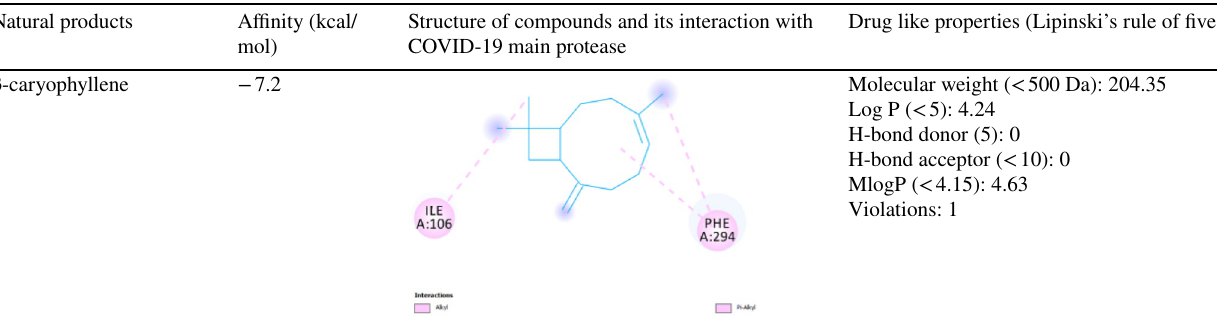
Fig. 1 Visualization of docking results showing binding of a glycyr- rhizin, b bicylogermecrene, c tryptanthrine, d β-sitosterol, e indiru- bin, f indican, g indigo, h hesperetin, i crysophanic acid, j rhein, k berberine and l β-caryophyllene inside the pocket of COVID-19 main protease with ligand as blue color sticks